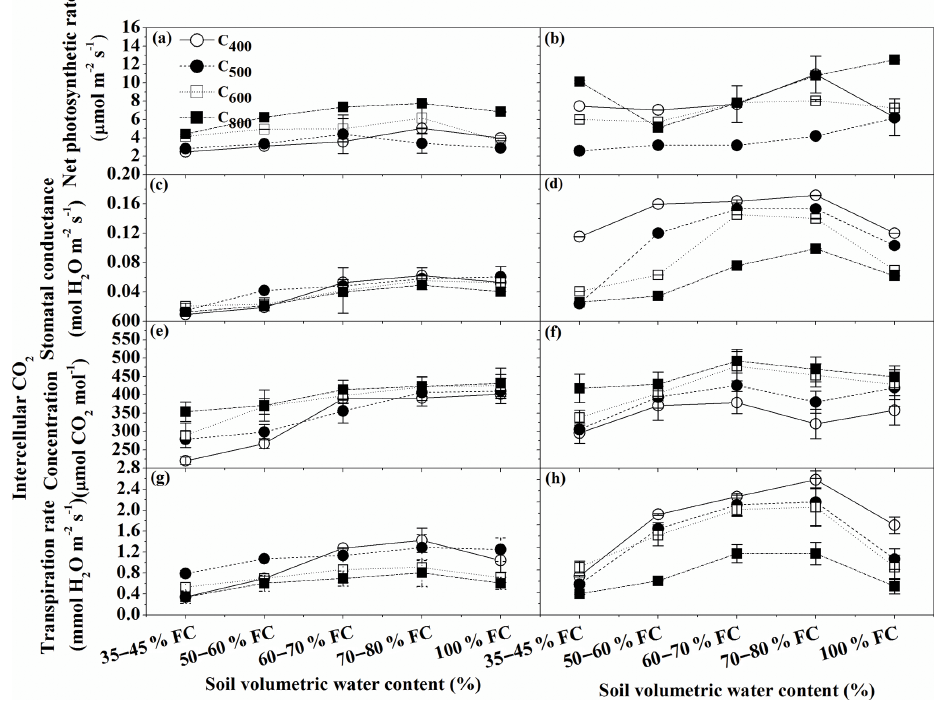
Figure 2. Net photosynthetic rates ( P n , µmolm − 2 s − 1 ; a , b ), stomatal conductance ( g s , molH 2 Om − 2 s − 1 ; c , d ), intercellular CO 2 con- centration (C i , µmolCO 2 mol − 1 ; e , f ), and transpiration rates ( T r , mmolH 2 Om − 2 s − 1 ; g , h ) in P. orientalis and Q. variabilis for four CO 2 concentration × five soil volumetric water content treatments. Means ± SDs, n =